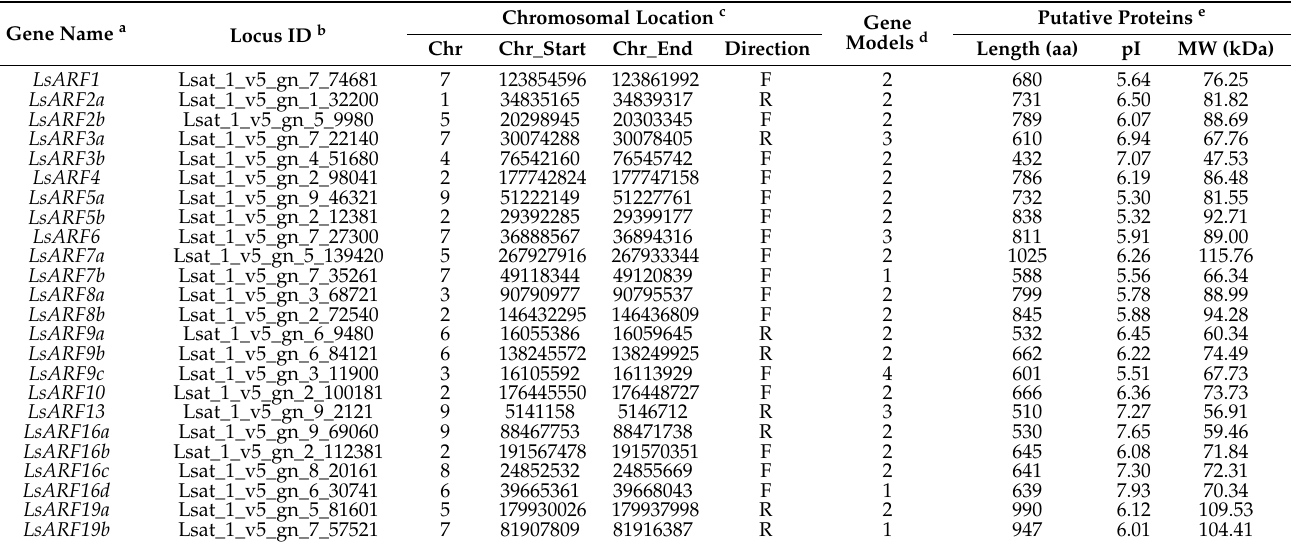
Table 1. List of putative the gene family of auxin response factors in the L. sativa